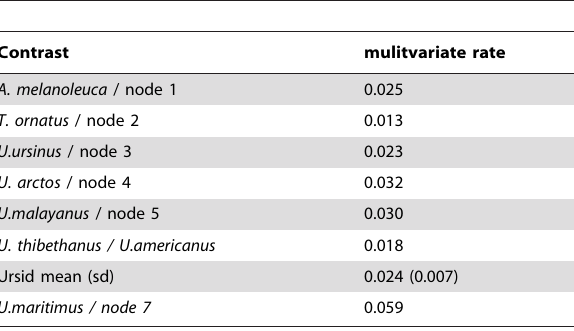
Table 1. Mulitvariate evolutionary contrasts for ursid cranial shape.